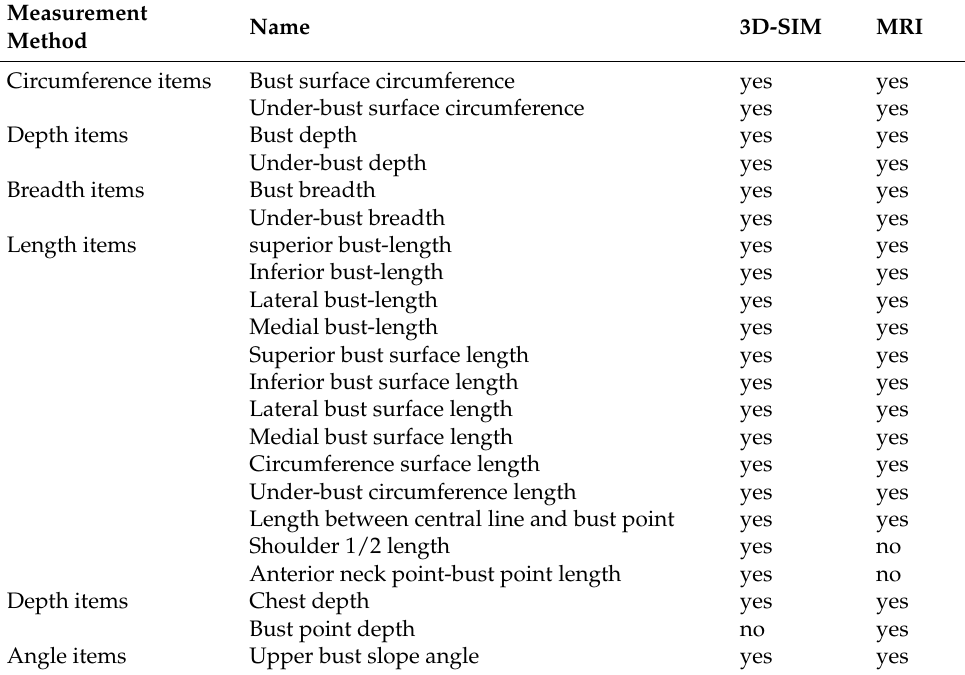
Table 6. Comparison of items depending on image acquisition